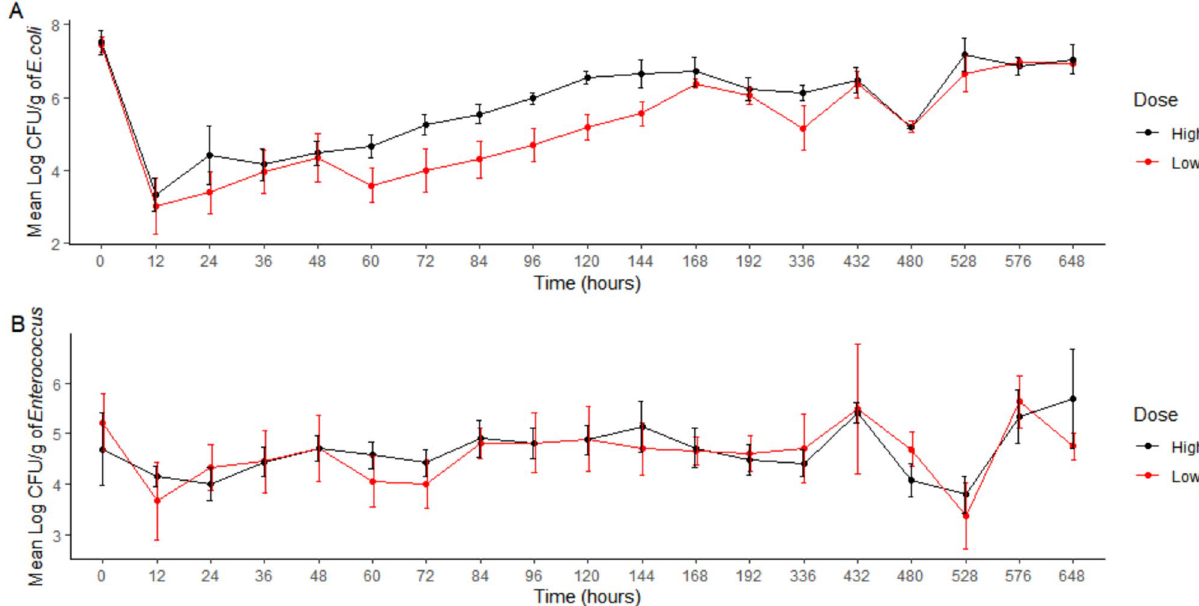
Figure 3. Mean Log CFU/g of E. coli and Enterococcus per dosing group over time with standard error. ( A ) Shows the Mean log CFU/g of E. coli while ( B ) shows the mean log CFU/g of Enterococcus. The black line is the high dose group and the red line is the low dose group. Individual t-tests with a Bonferonni correction (p < 0.0125) were performed for overall log CFU/g at predetermined time points. The only significant difference seen for E. coli was comparing Day 0 to Day 6 for the low dose group only (p = 0.0006). There was no significant differences noted for Enterococcus